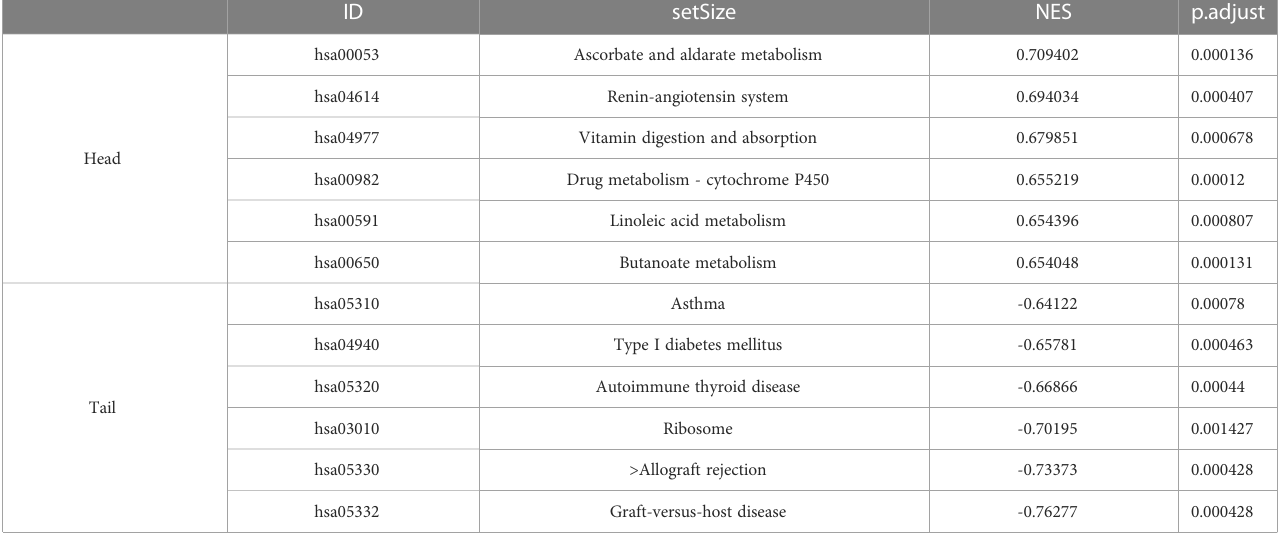
TABLE 3 Single-gene GSEA of AFM. ID setSize NES